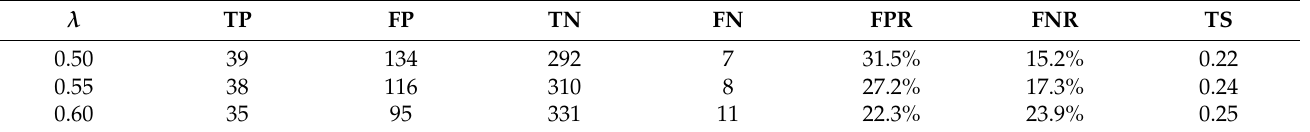
Table 1. Comparison table for the selection of the RI probability threshold for model prediction.